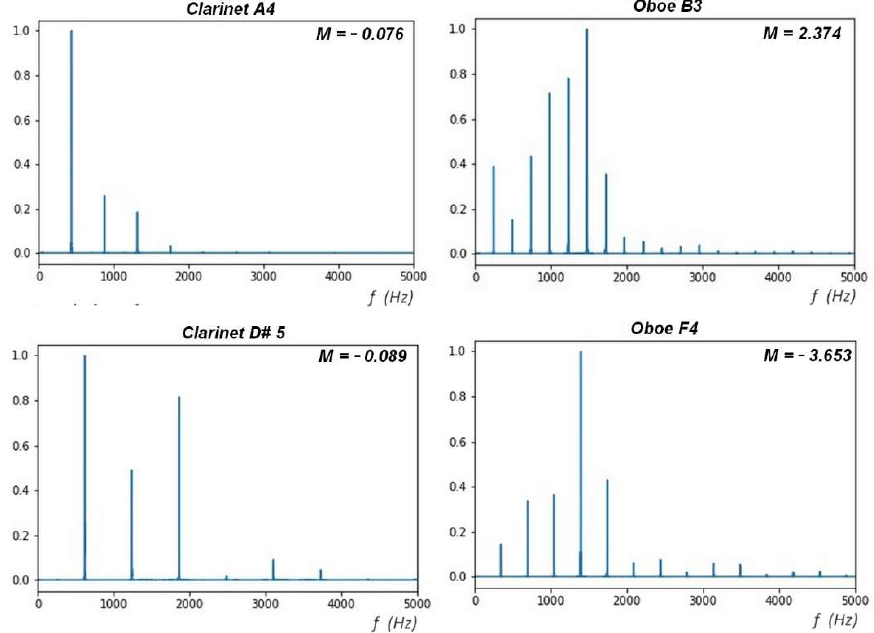
Figure 9. Effect of monotony on FFT spectra. Decreasing sound A4 Clarinet (left), increasing sound B3 Oboe and alternates, Clarinet D#5, and F#4 Oboe.